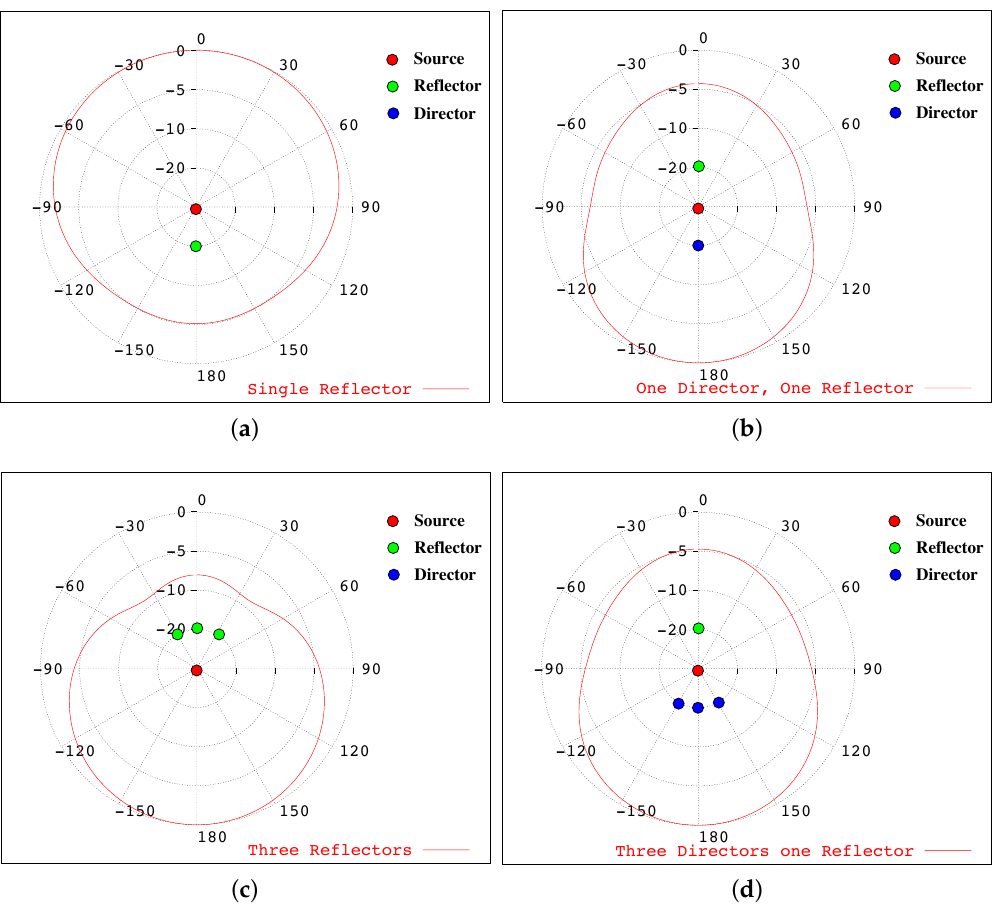
Figure 2. Beam pattern for different parasitic structure configurations. ( a ) single reflector; ( b ) single reflector and director; ( c ) three reflectors; ( d ) three directors and one reflector.